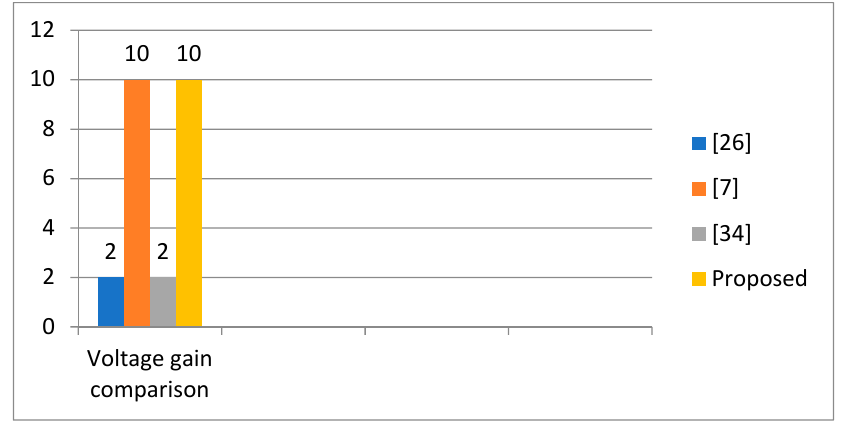
Figure 35. Voltage gain comparison.